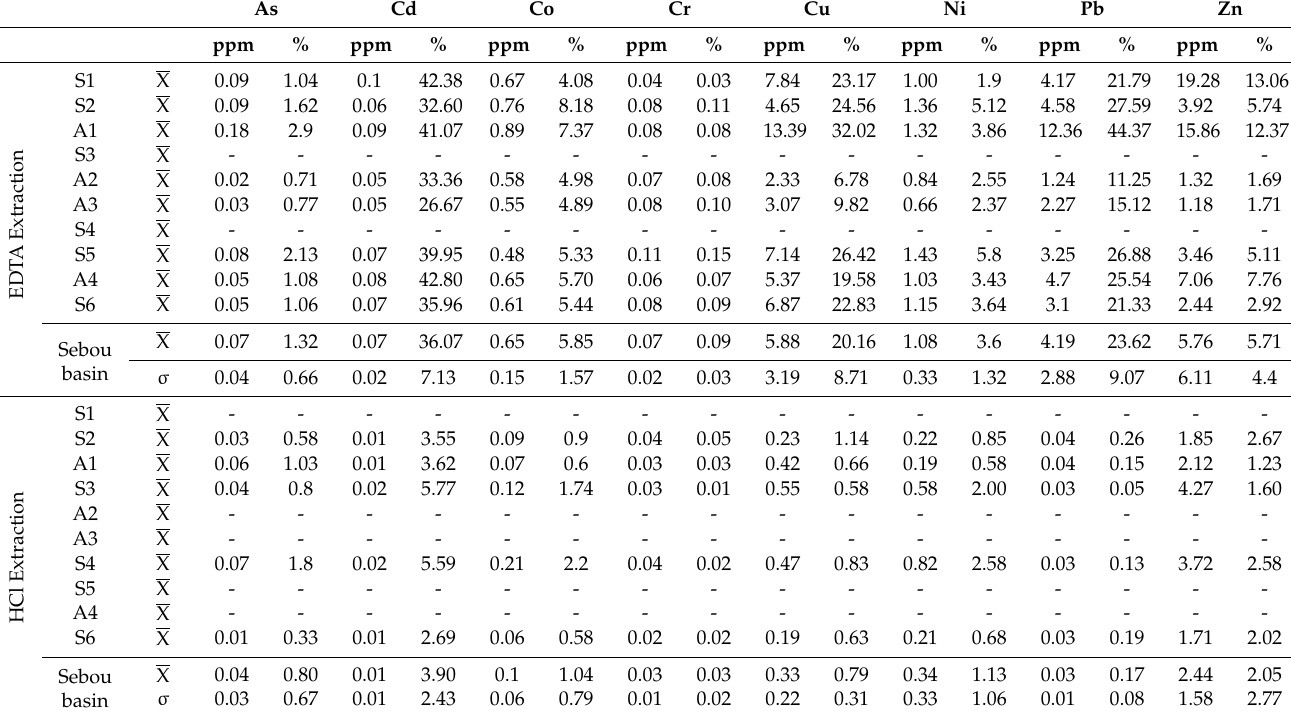
Table 2. Average trace metal concentrations of the available fraction ( µ g · g − 1 ) and proportion of the total concentration (%) in sediments using EDTA extraction for the stations sampled in 2018 and HCl extraction for some stations (S2, A1, S3, S4, S6).